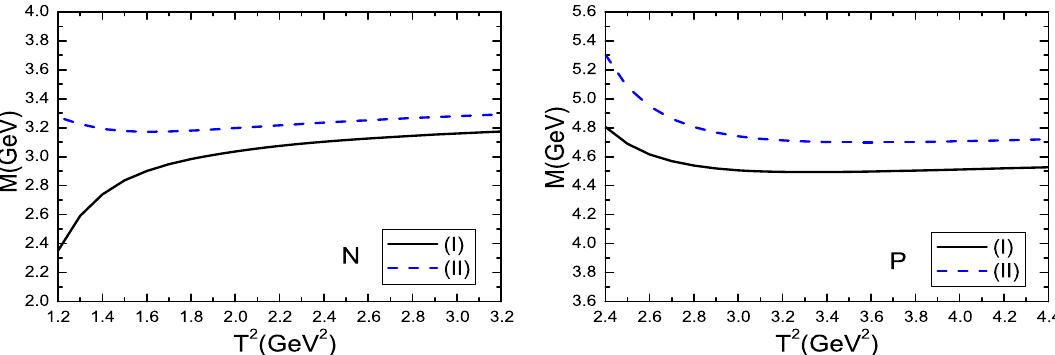
− ) − ) + ) + ) , ( sssc ¯ s , 3 , ( uuuc ¯ u , 3 , and ( sssc ¯ s , 3 , respectively 2 2 2 2